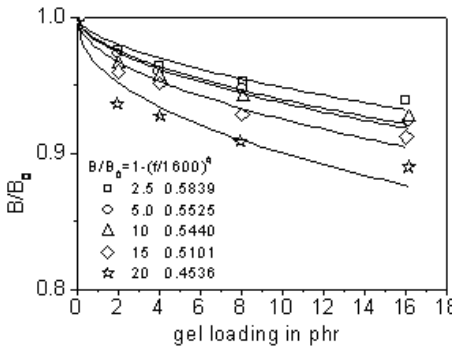
crosslinked NR latex gel-filled NR systems at 130 °C and 122.5 s -1 .